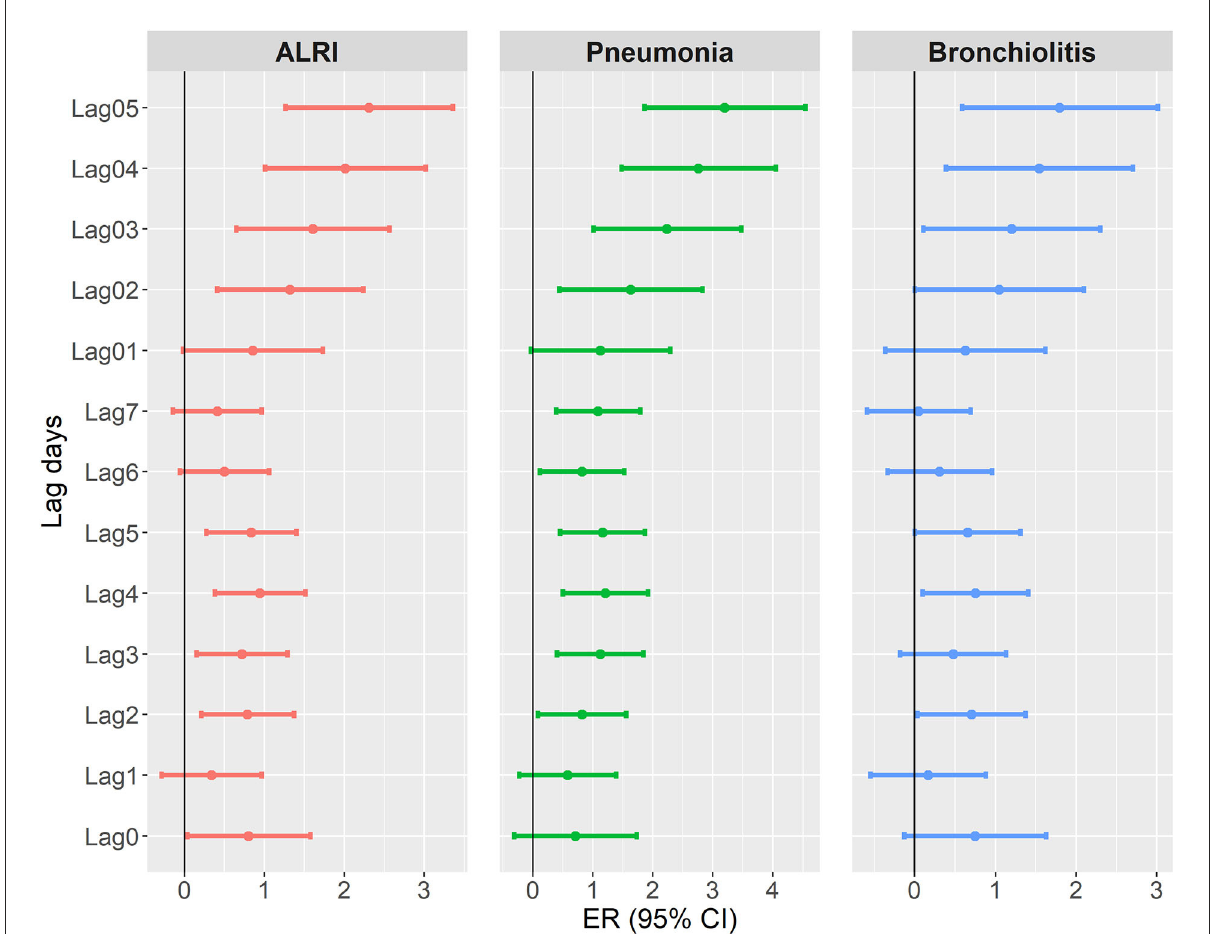
FIGURE1 Excess risk (and 95% confidence interval) of acute lower respiratory outpatient visits per 1 ◦ C increment in diurnal temperature range at different lag days (the number of days between exposure and the estimated